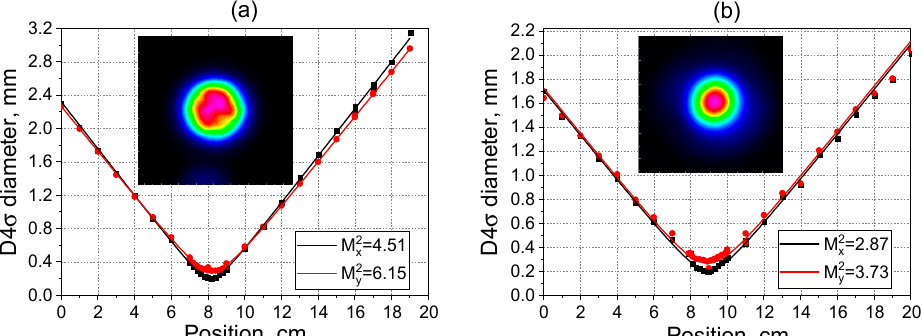
Figure 5. M 2 quality parameter measurements near the waist of the focused output beams of the RFL with open-space AOM: ( a ) for the generated 1st Stokes beam (1018 nm) at 20 W pump power and ( b ) for the 2nd Stokes beam (1064 nm) at 22 W pump power (~760 mW and 50 mW of the 1st and 2nd Stokes powers, respectively). Insets: corresponding intensity profiles near the beam waist.